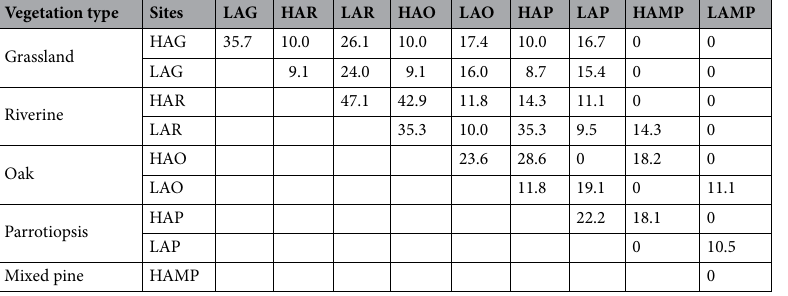
Table 6. Similarity index (%) of soil bacteria isolated from selected study sites falling under five vegetational types of lower Dachigam National Park,